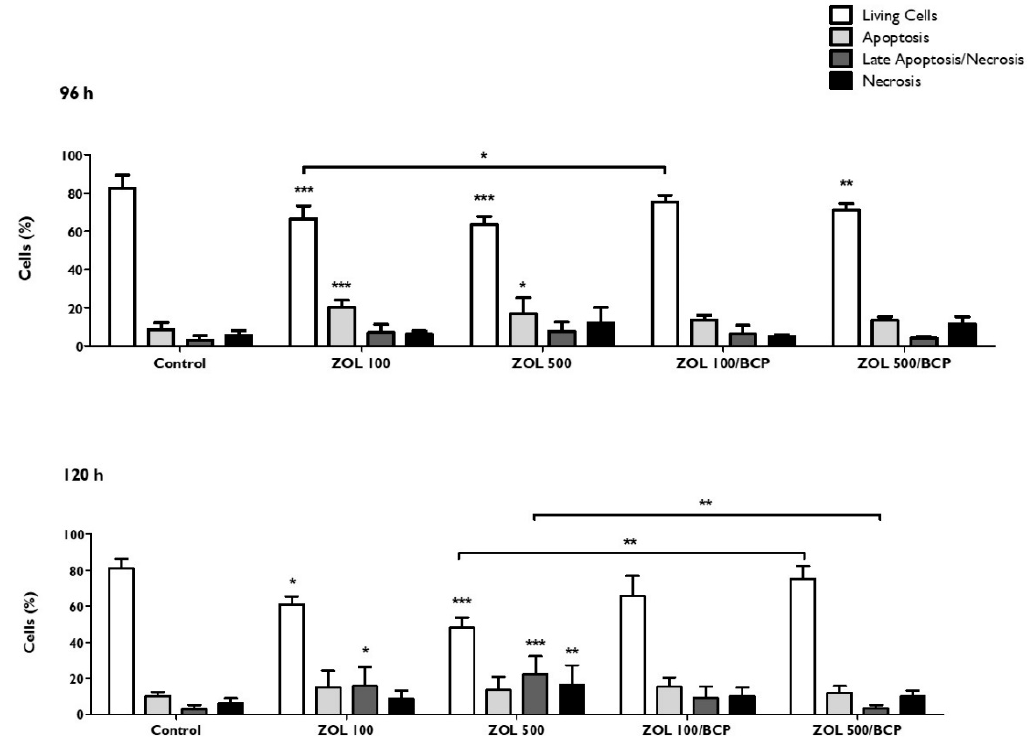
Figure 8. Types of cell death of HGF, 96 h and 120 h after treatment with ZOL and with ZOL/BCP. The results represent the mean and standard deviation of at least four tests. Significant differences are represented with *, where * means p < 0.05, ** means p < 0.01, and *** means p < 0.001.